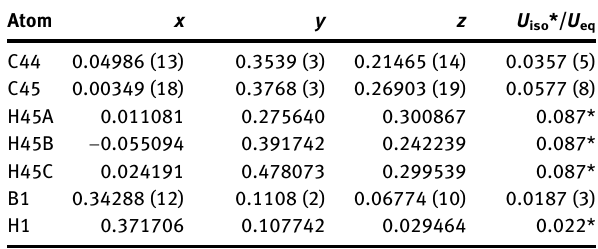
Table  : Fractional atomic coordinates and isotropic or equivalent isotropic displacement parameters (Å 